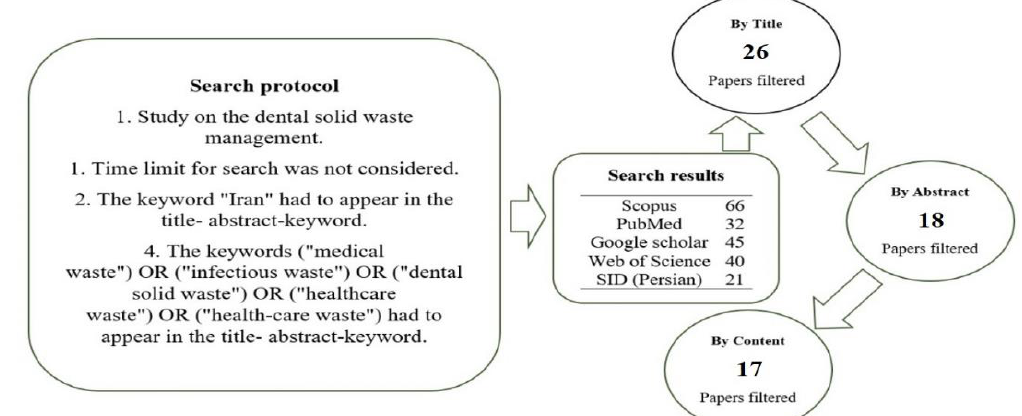
Fig. 1. Searching and selecting 17 final articles used in review